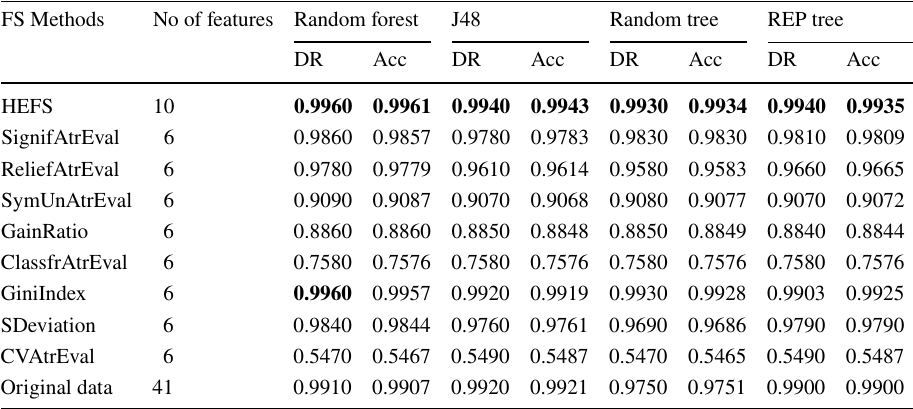
Bold fonts indicate the best results obtained